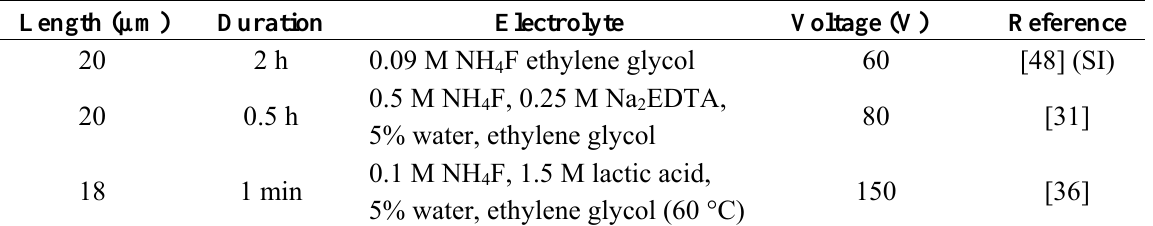
Table 2. Experimental conditions to achieve efficient